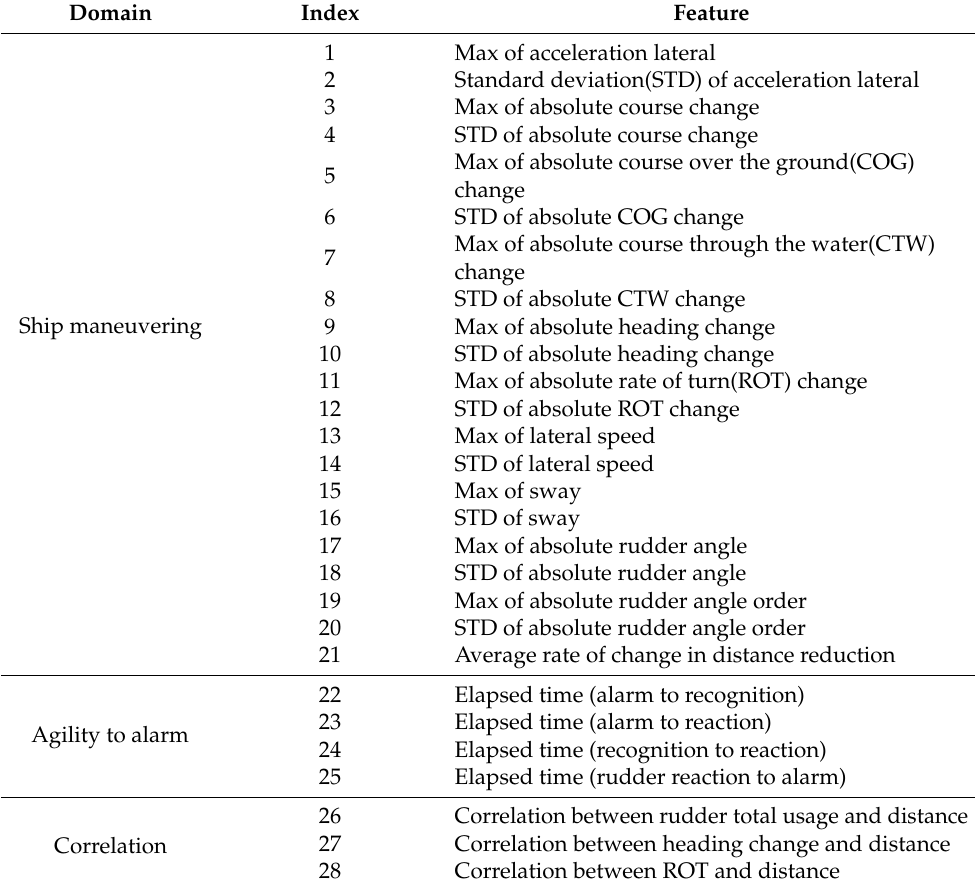
Table 3. Extracted feature